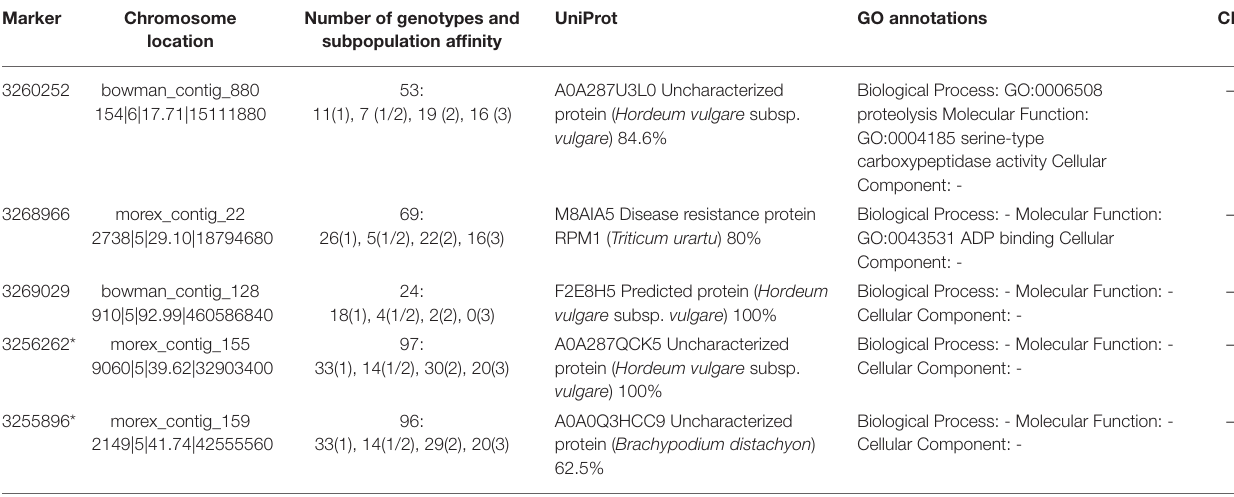
TABLE 3 | Gene annotations of DArTseq and SNP markers associated with energy trapping efficiency in PSII (F v /F m ) in well-watered barley (control).